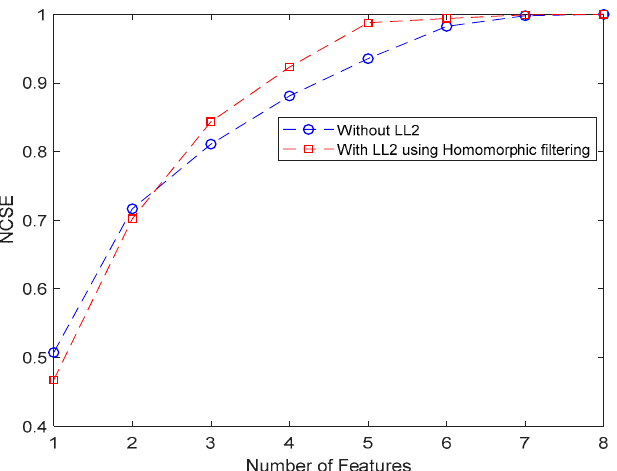
Figure 6. Normalized cumulative summation of eigenvalues of training data for GARCH (1, 1) with and without LL2 (two-classes).